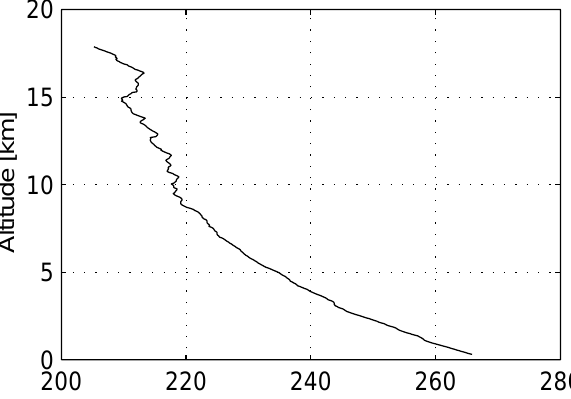
Fig. 6. Temperature profile from a radiosonde launched at Esrange on 9 January